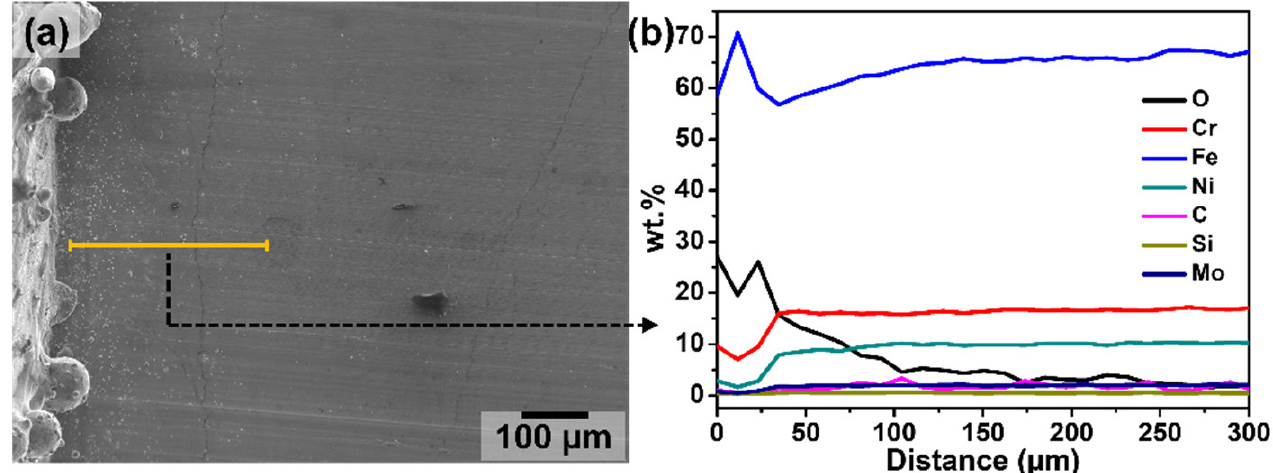
Figure 4. ( a ) Secondary electron image of a region around the HAZ, and ( b ) energy dispersive X-ray (EDX) composition analysis of a line scanned across the HAZ.